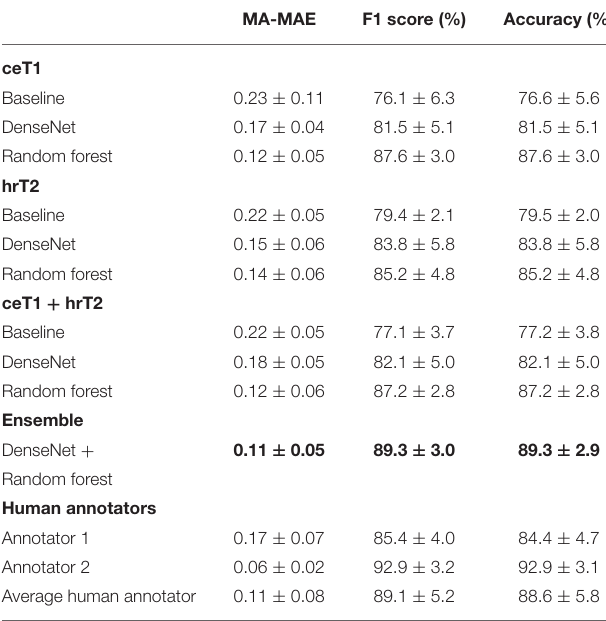
TABLE 2 | Comparison of F1-score obtained with different classifiers and with different types of input data and modalities assessed on a single fold of the dataset.